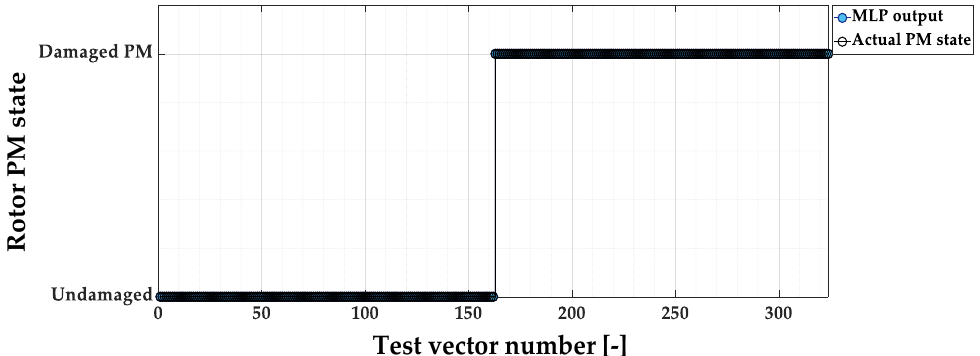
Figure 16. MLP-based PM magnet damage detector responses during to the test vectors.